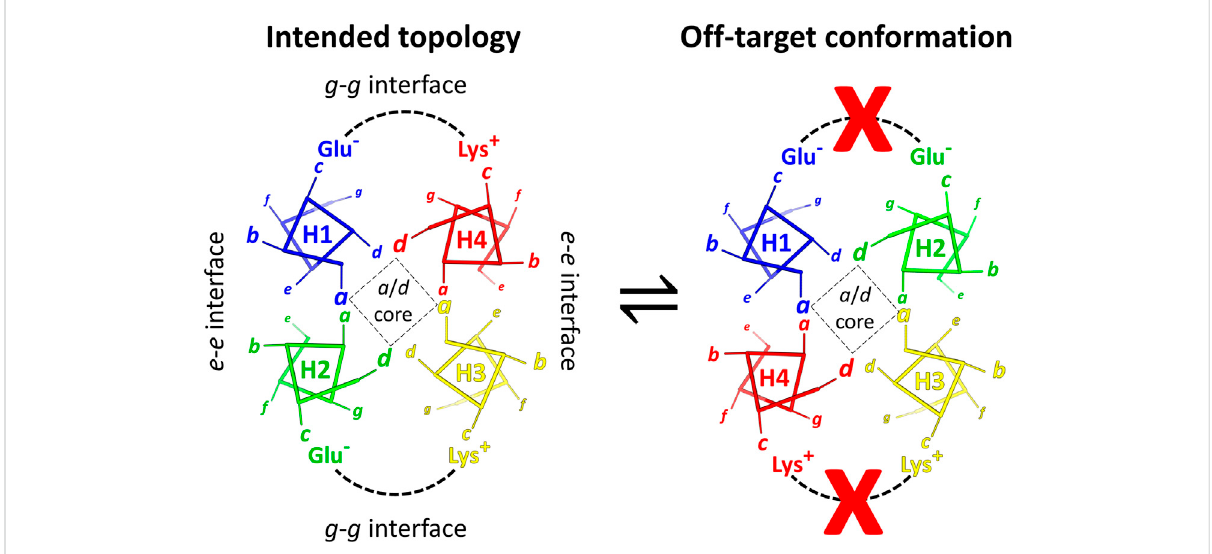
FIGURE 1 Helical wheel diagrams show how charge pairing interactions disfavor a misfolded state. Left: the correctly-folded antiparallel coiled coil structurehasfavorableGlu – Lysinteractions.Right:helicesH2andH4aretransposedinthemisfoldedstate,creatingGlu – GluandLys – Lyscharge clashes as indicated by the red Xs. For each helix, one example heptad is displayed. The distance of an amino acid from the viewer is represented by the size of its heptad letter designation. In helices, thick sticks connect C α atoms, while thinner lines represent C α -C β